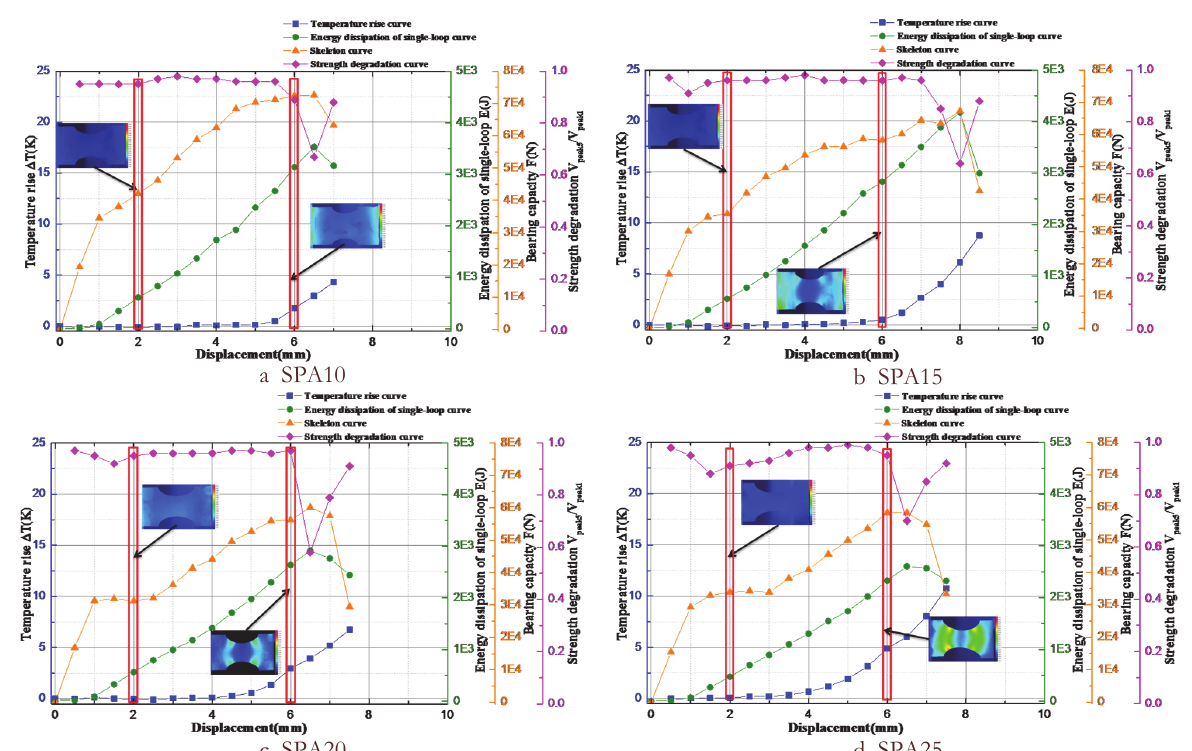
Figure 9: The relationship between the mechanical performance and average temperature rise for dampers of SPA with four different opening ratios.